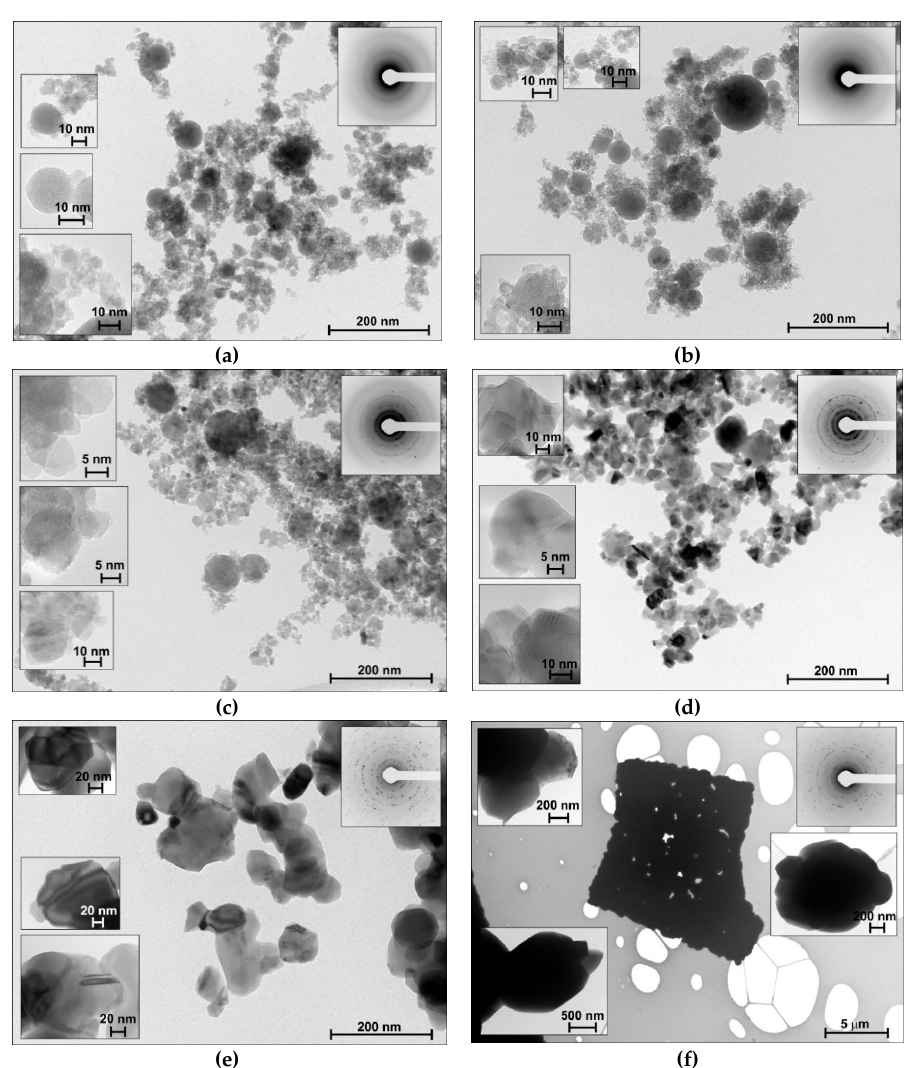
Figure 1. TEM data for the materials: ( a ) TiO 2 _ini, ( b ) TiO 2 _200, ( c ) TiO 2 _400, ( d ) TiO 2 _600, ( e ) TiO 2 _800, ( f ) TiO 2 _1000. Right top corner insets: Selected area electron diffraction (SAED) data.